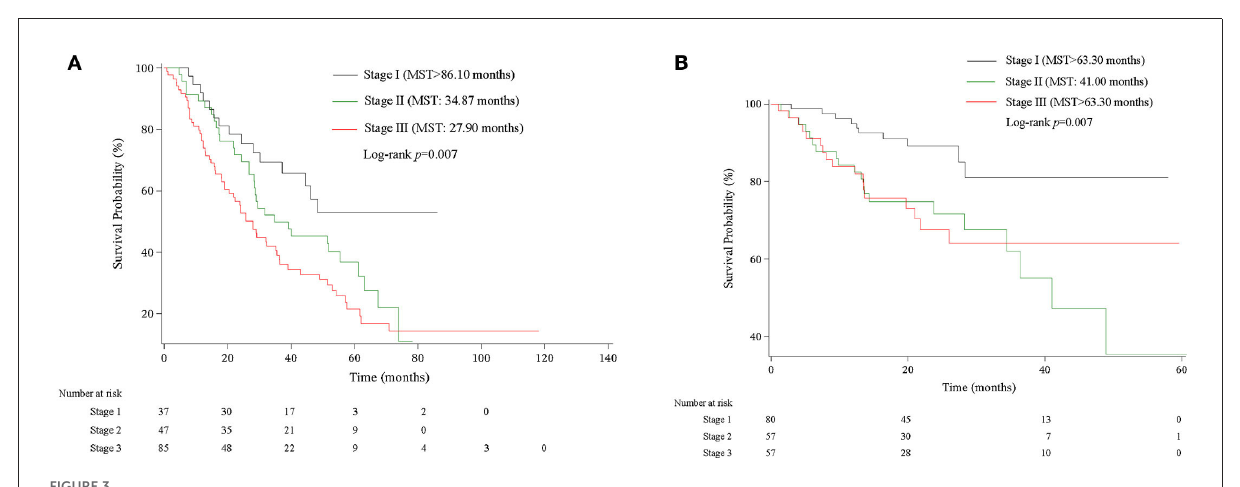
FIGURE2 Nomogram for CPB model.